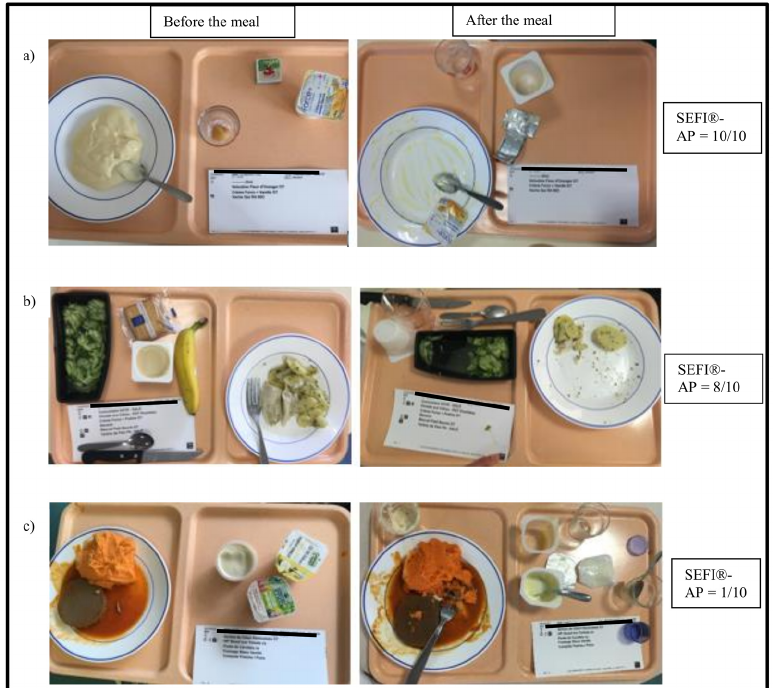
Figure 1. Three examples (a–c) of scoring of the Simple Evaluation of Food Intake ® assisted by photography (SEFI ® -AP). Photographs of the meal trays before (left column) and after food intake (right column) were analyzed and the SEFI ® -AP was scored by comparing the served to consumed food portions. A/Meal tray completely consumed: SEFI ® -AP=10/10. B/More than ¾ of the meal tray consumed: SEFI ® -AP=8/10. C/Less than ¼ of the meal tray consumed: SEFI ® -AP=1/10.